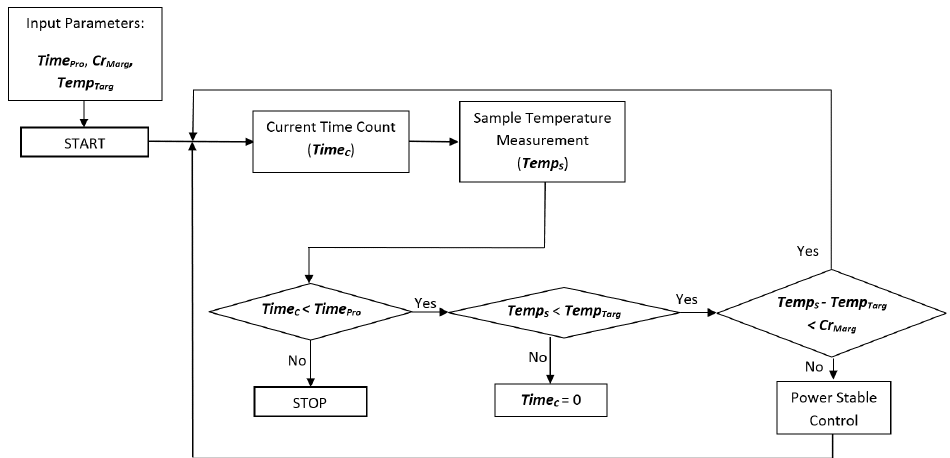
Figure 3. Flow diagram of the adaptive procedure obtaining the desired temperature during the microwave treatment time, by considering processing time ( Time Pro ), current time ( Time C ), critical margin ( Cr Marg ), sample temperature ( Temp S ), and target temperature ( Temp Targ ). For the sterilization process, heating over 100 °C must be carried out. For this purpose, a